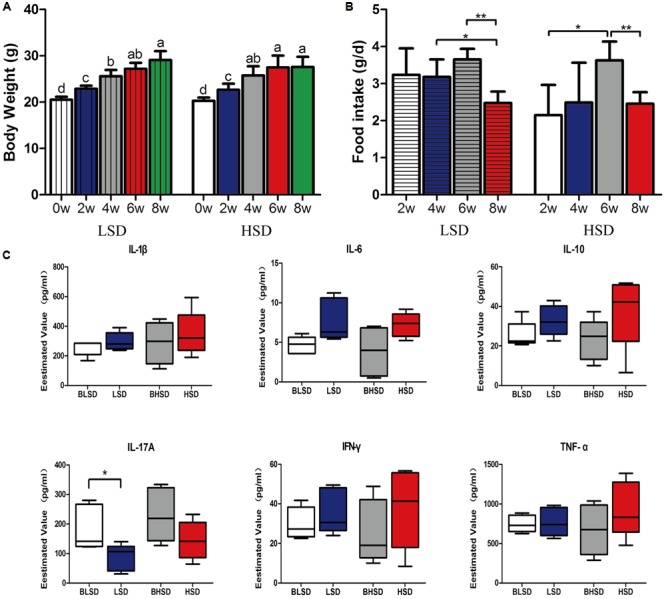
Growth performance and physiological responses of mice. (A) The changes of body weight. Each column represents one group. (B) The changes of feed intake. (C) Box-plots of serum inflammatory factors. The asterisk (∗) indicates significant difference between two groups (P < 0.05, two sample t-test). ∗P < 0.05; ∗∗P < 0.01. Note: The data were analyzed by one-way analysis of variance and means were compared by two sample t-test. BLSD, low-salt diet group before feeding; LSD, low-salt diet group after feeding; BHSD, high-salt diet group before feeding; HSD, high-salt diet group after feeding.